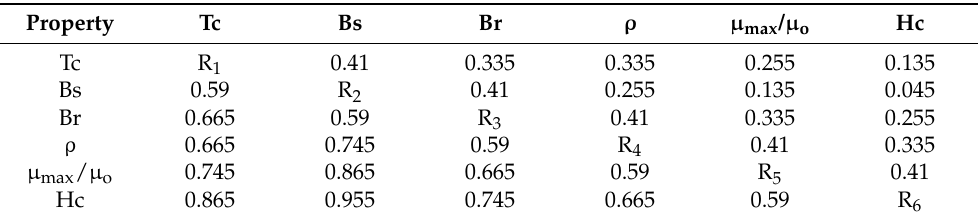
Table 8. Decision matrix from relative importance of material selection factor (11-point